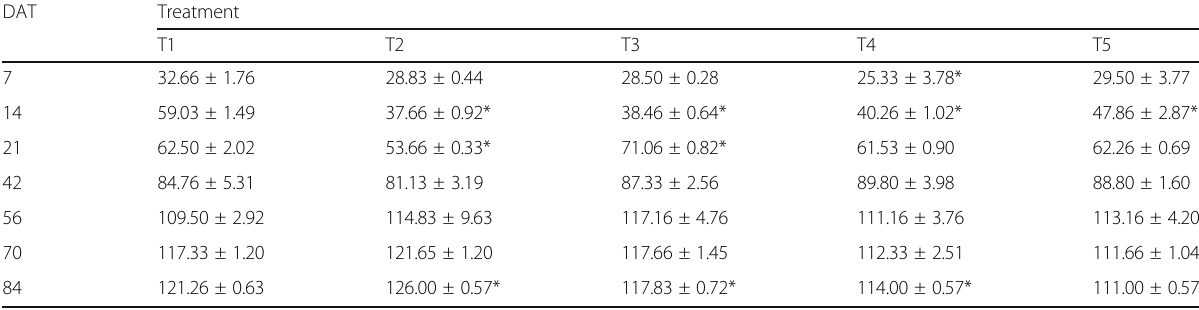
Table 2 LSD test-based plant height (cm) parameters (mean ± standard error) during the crop growth period (values marked with * indicate significant difference at a significance level of 5% in comparison with the corresponding value under T1 in the same column)